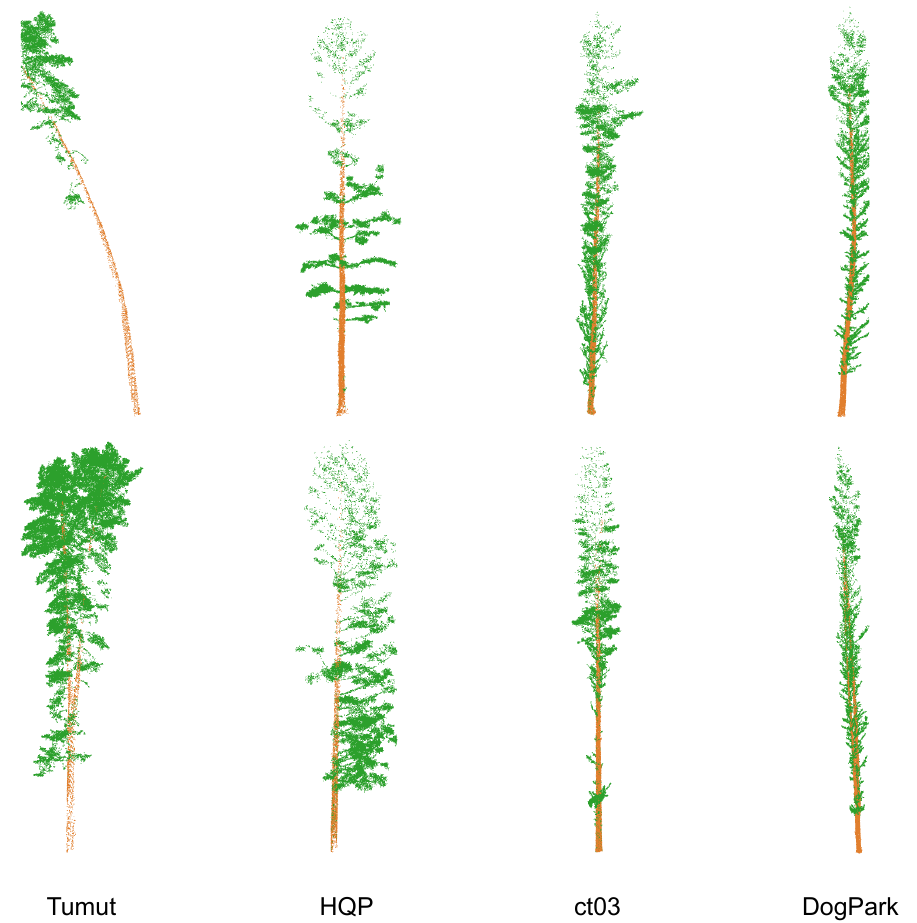
Figure 6. Visualisation of some tree point clouds from our Tumut, HQP, ct03, and DogPark datasets. Best viewed in colour.